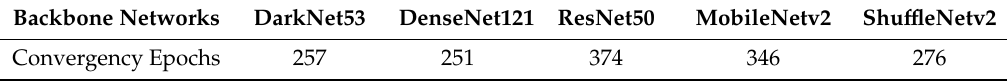
Table 5. Convergency epochs of YOLOv3 based on various backbone